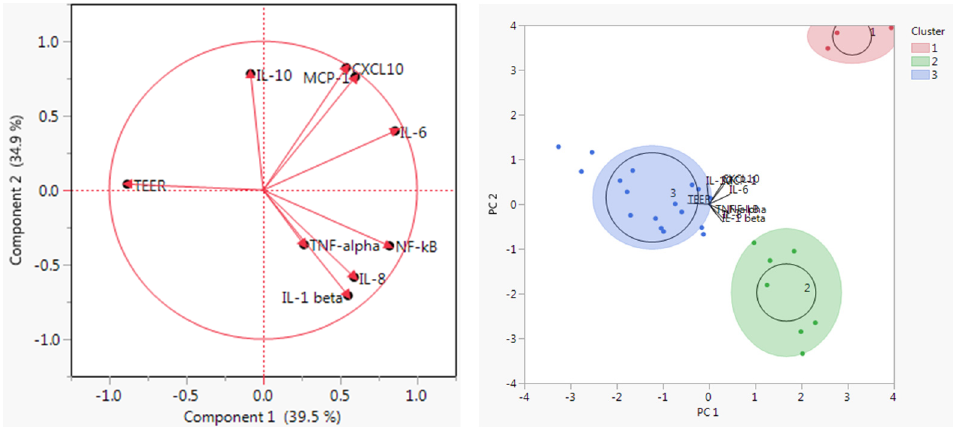
Figure 1. Principal Components Analysis and K means clustering. The principal components were selected based on the two highest eigenvalues and explained 74.4% of the variability. Three distinct clusters were detected after visual inspection: the red cluster (1) contained soybean meal, the green cluster (2) contained the bacterial meals, and the blue cluster (3) contained the yeast, algae, fish meal, and insect meal.